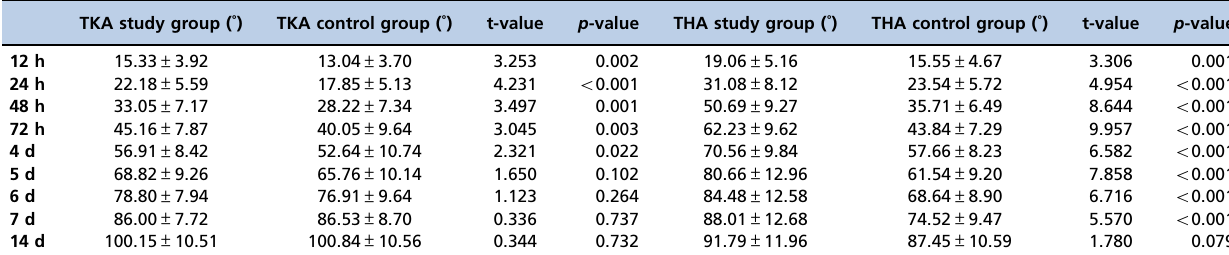
Figure 3 - *The NRS scores at rest. The average score in the TKA study group was lower than that in the control group at 12 h, 24 h, and 48 h, whereas the average score in the THA study group was lower than that in the control group at 12 h, 24 h, 48 h, 72 h, 4 d and 5 d. Table 4 - Range of motion after the